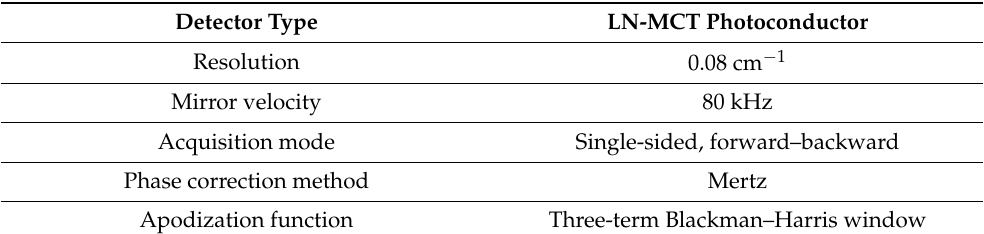
Table 1. Parameters used for the transmission measurements with the FTIR spectrometer (Vertex 80v, Bruker).